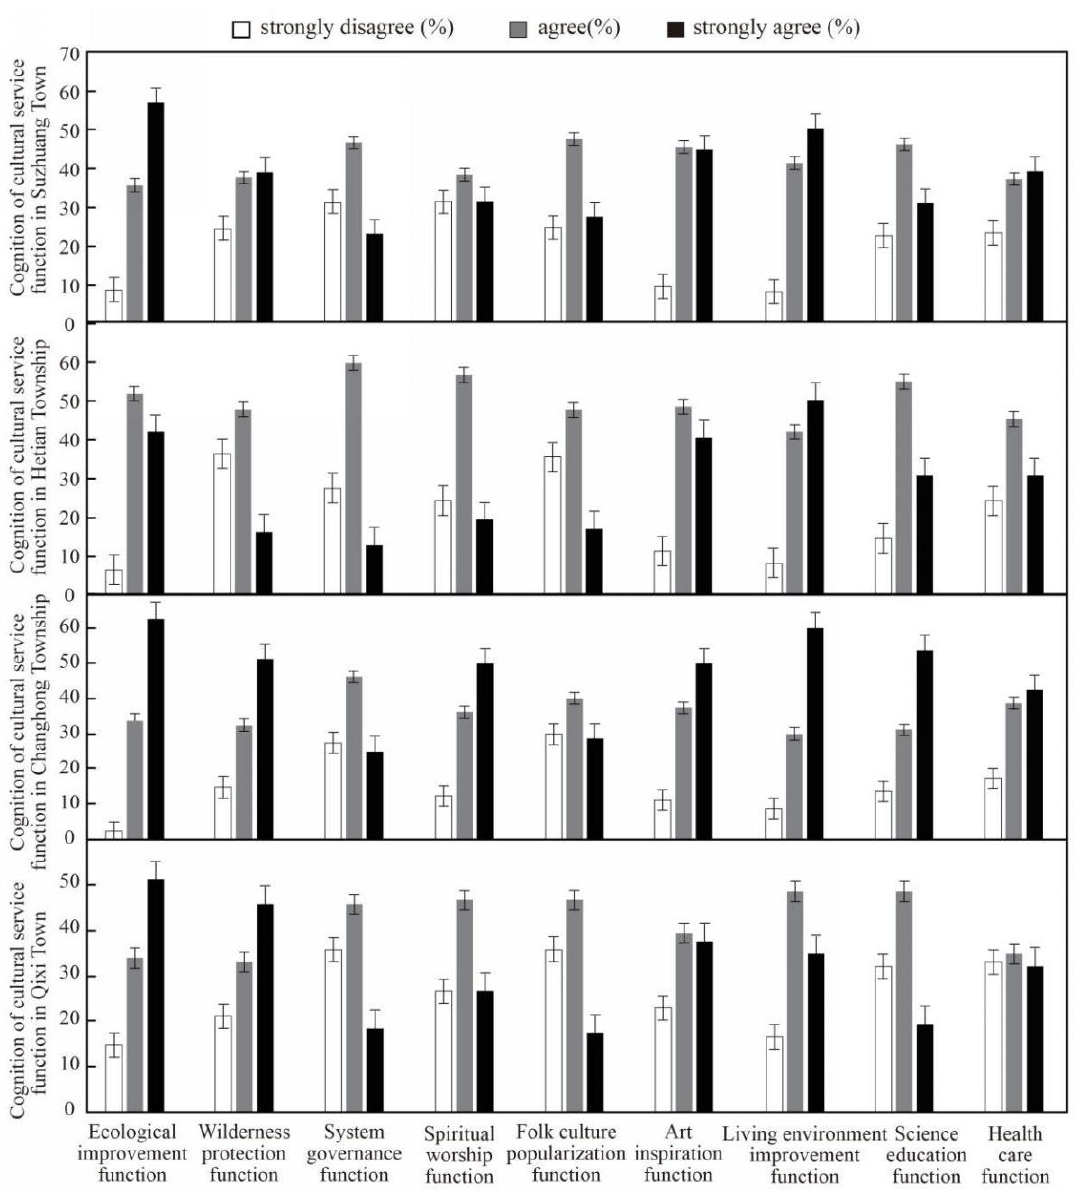
Figure 3. Cognition of cultural service function in different towns.